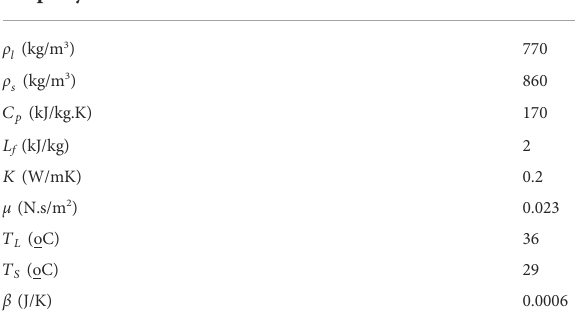
TABLE 2 Thermodynamic properties of the PCM used in this study (Najim et al., 2022). Property